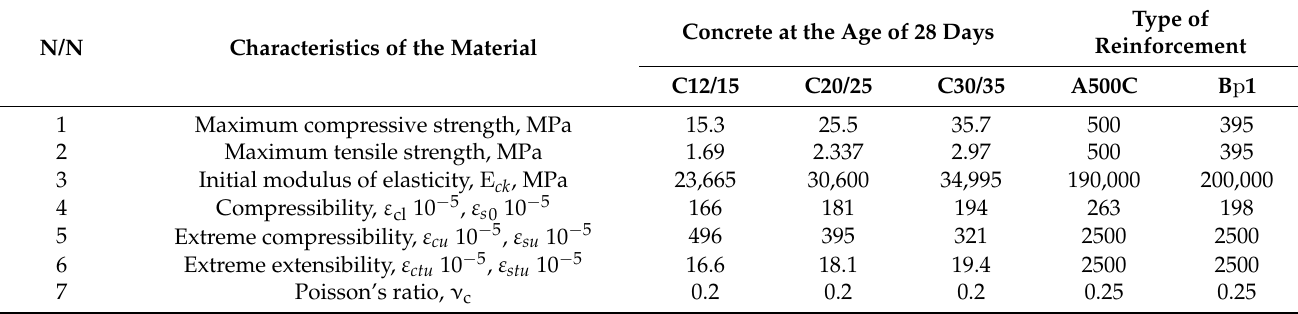
Table 1. Nominal physical and mechanical characteristics of